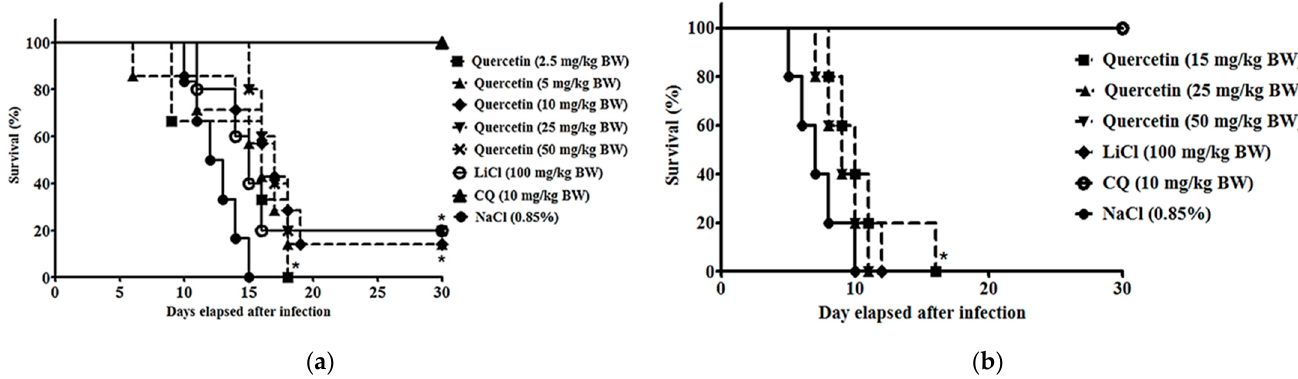
Figure 1. Representative Kaplan–Meier survival curve during the four-day suppressive test in ( a ) P. berghei NK65-infected mice and ( b ) ANKA-infected mice with and without quercetin. Figures show survival data for NaCl-treated (negative control) ( n = 7), quercetin-treated (n = 7), CQ-treated ( n = 7), and LiCl-treated ( n = 7) mice. Significant differences between tested and control groups were determined at p < 0.05 (*).